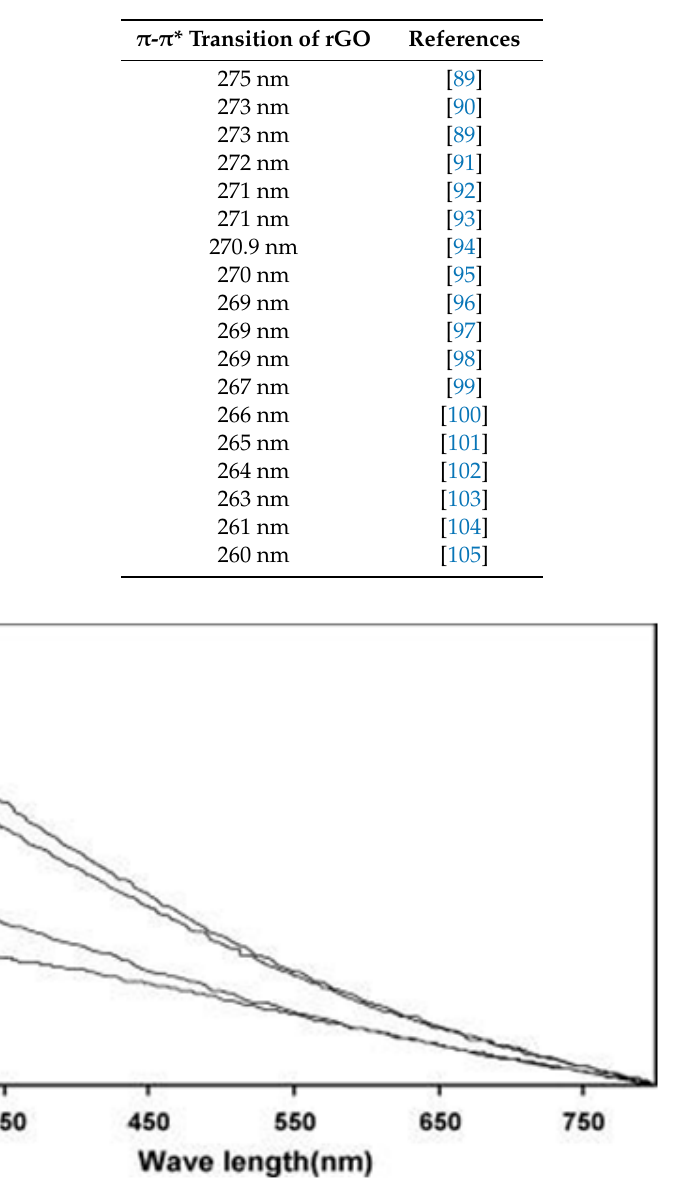
Figure 9. UV–vis absorption spectra for dispersion efficiency of various types of CB in aqueous solution. Reproduced with permission from [80], Elsevier, 2009.